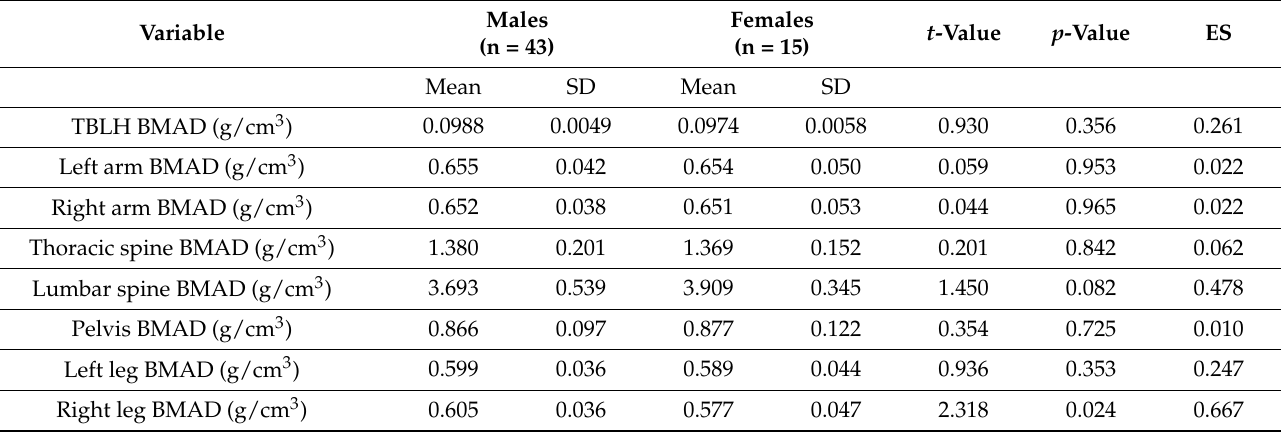
Table 4. Bone mineral apparent density (BMAD; g/cm 3 ) in male and female karatekas. Mean ± standard deviation (SD). Student’s t -test.